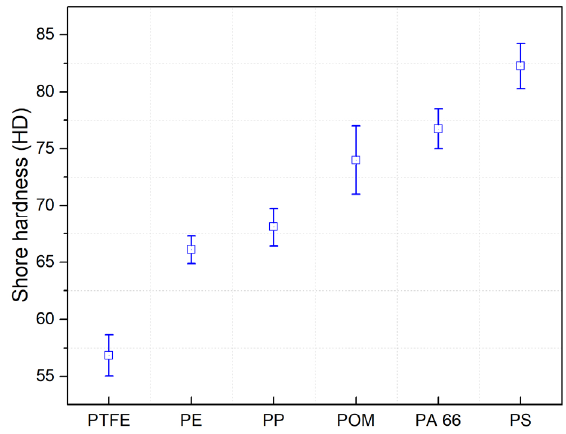
Fig. 2 Shore hardness of the polymer